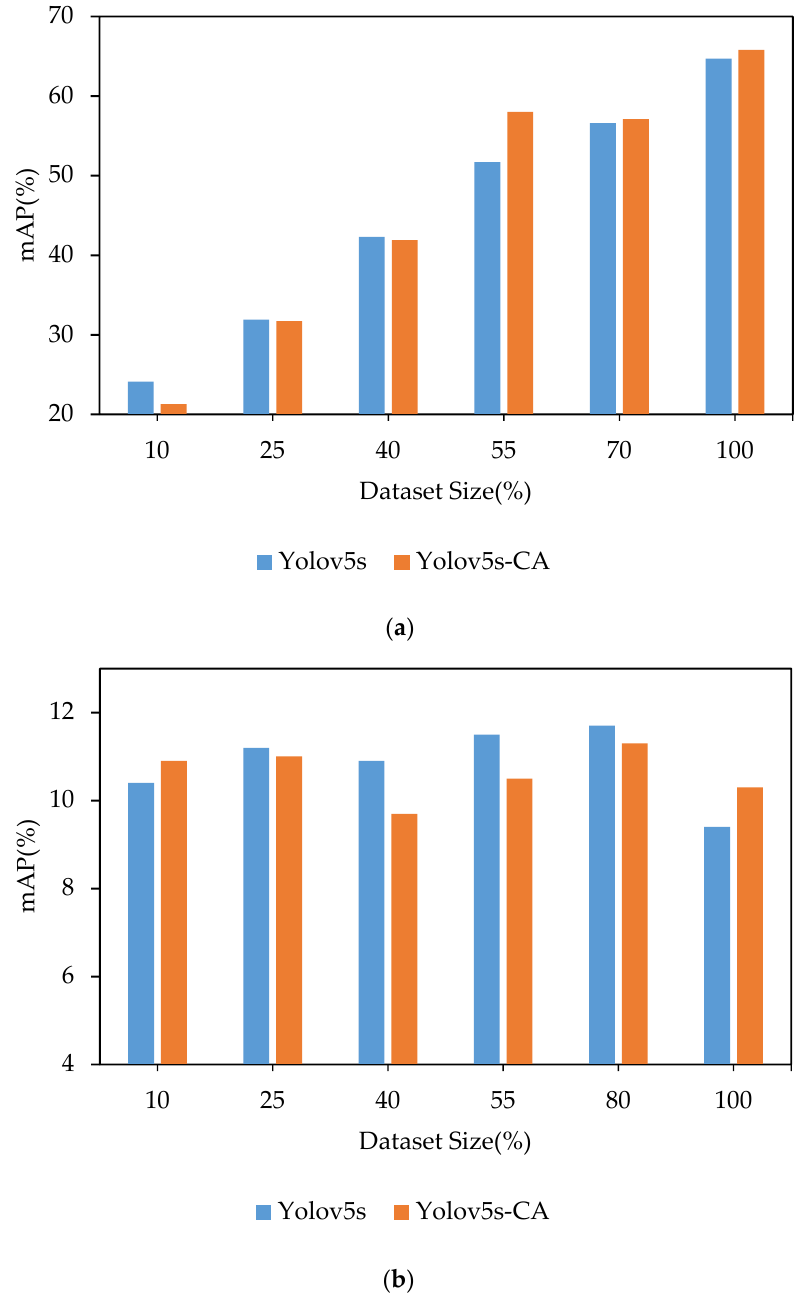
Figure 6. Effects of training data size. ( a ) Field-collected dataset. ( b ) Synthetic dataset. Table 1. Performance comparisons of models trained only on real field dataset.